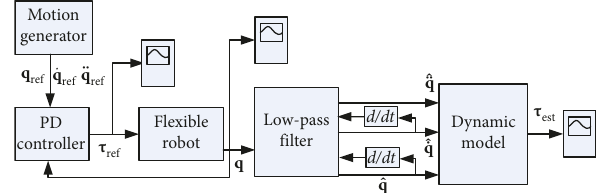
Figure 8: Experimental scheme and data recording.